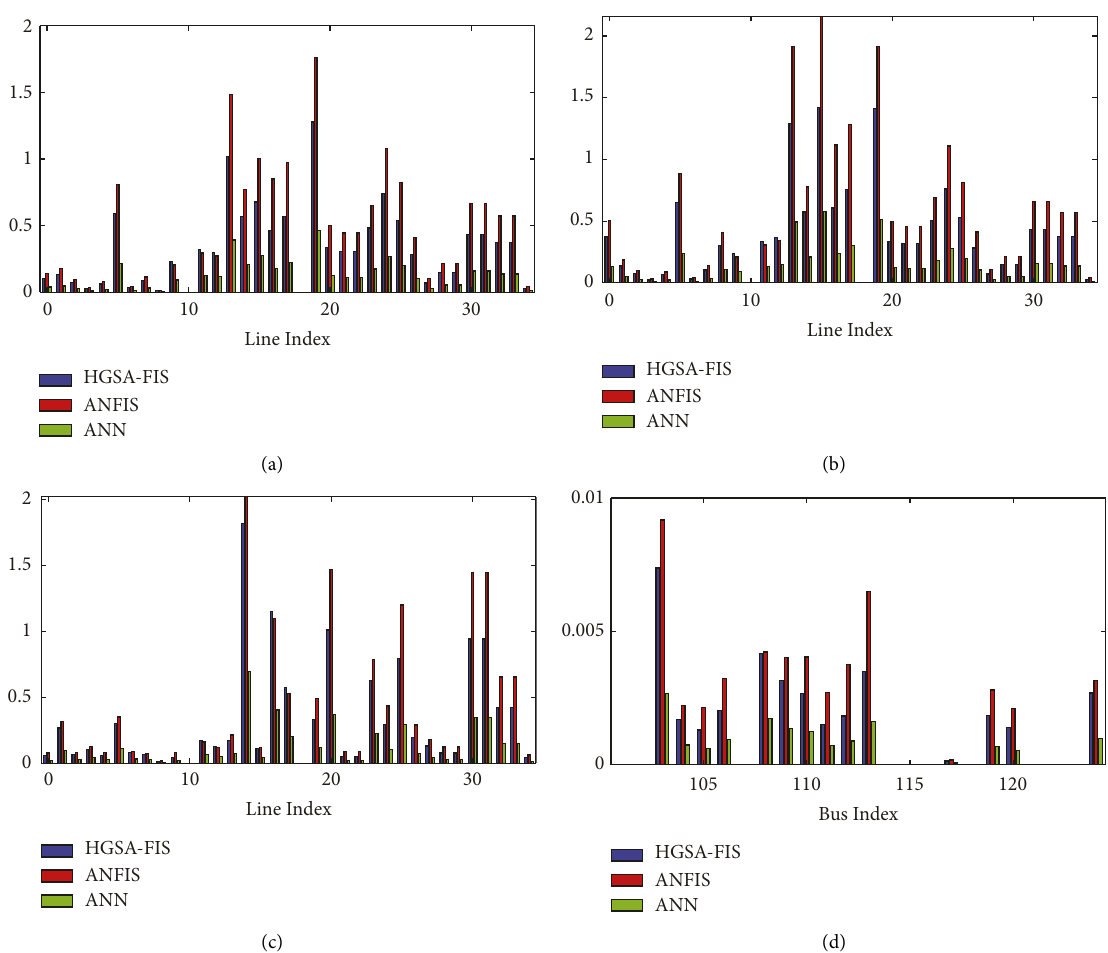
Figure 18: Performance of equivalents as measured by WAPE (%), (a) percent line loading deviation, (b) lines active power flow deviation, (c) lines reactive power flow deviation, and (d) buses voltage deviation. Table 6: Maximum WAPE (%) of HGSA-FIS-, ANFIS-, and ANN-based equivalents. Maximum WAPE Grid parameter